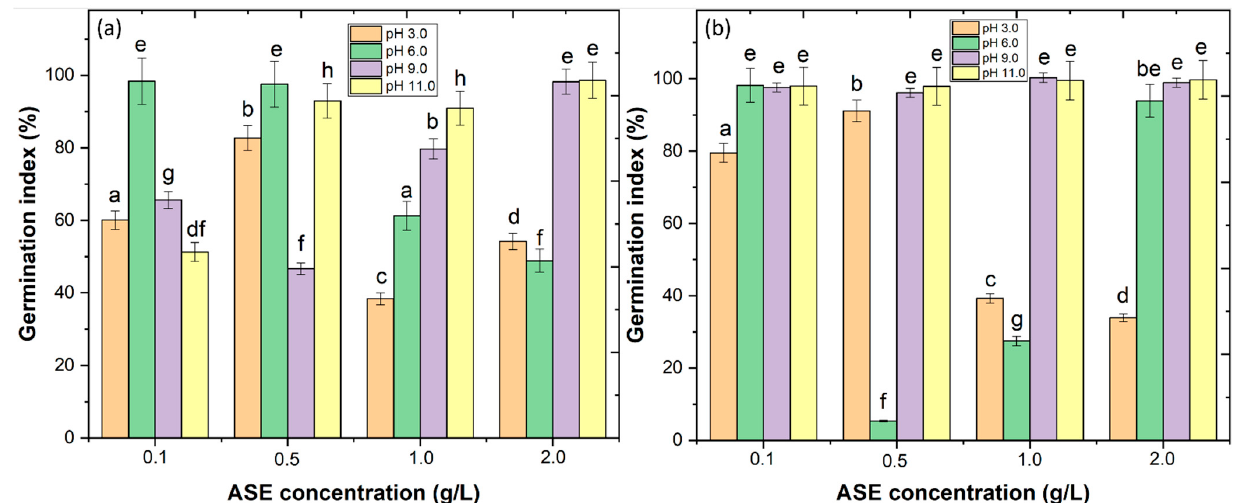
Figure 3. Effect of ASE concentration vs. pH in ( a ) germination index of cucumber and ( b ) corn seeds. Means in bars with different letters represent significant differences ( p < 0.05) within each ASE concentration by comparing the pH.